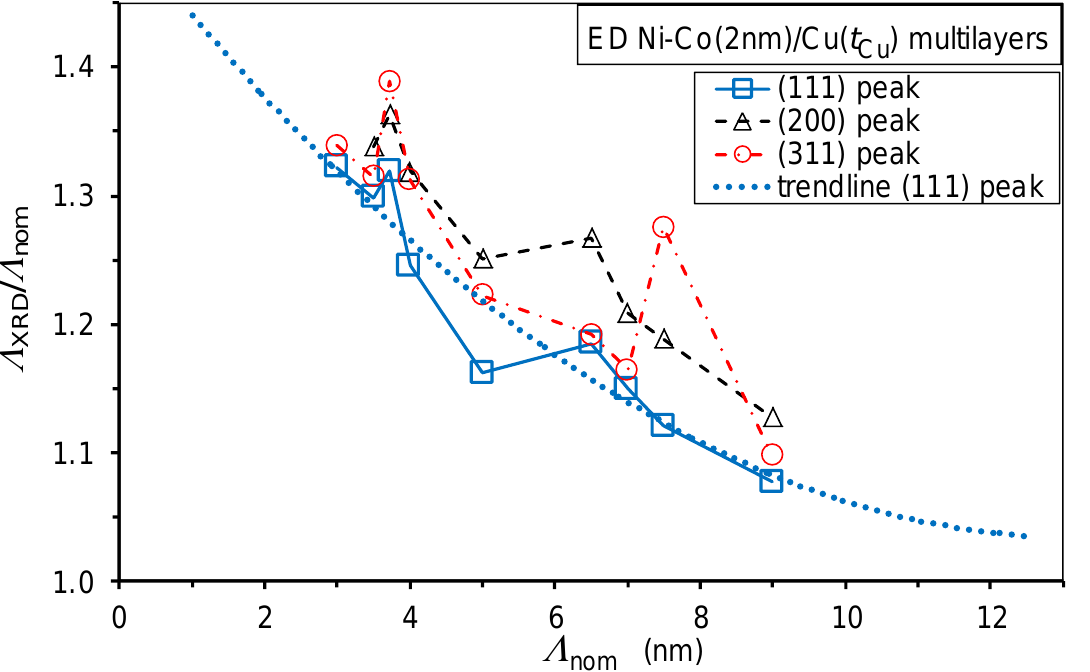
Figure 2. XRD pattern (black line) around the fcc(200) reflection (left panel) and around the fcc(311) reflection (right panel) for the Ni-Co/Cu multilayer with t Cu = 1.5 nm thick spacer layer (sample 22). The green line represents the fit for the main reflection (peak 2), and the blue lines represent the fits for the lower-angle satellite peak S − (peak 1) and the higher-angle satellite peak S + (peak 2). The red line is the sum of the three fitted peaks. From the satellite peak positions, the bilayer length was obtained as Λ XRD = 4.7 nm for the (200) reflection and Λ XRD = 4.6 nm for the (311) reflection. The satellites around the main reflection (111) yielded Λ XRD = 4.5 nm whereas the nominal bilayer length was Λ nom = 3.5 nm.